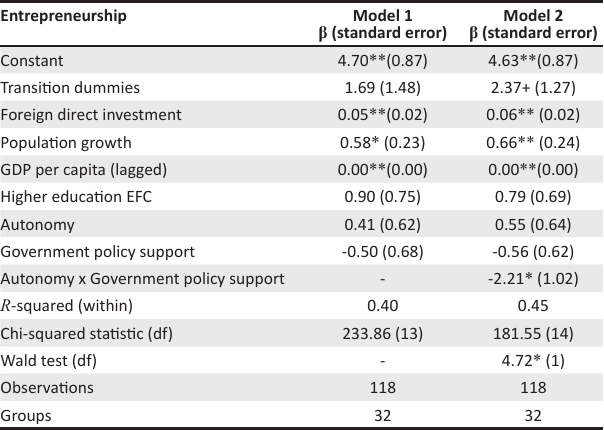
TABLE 2: Regression models (robust standard errors and centred